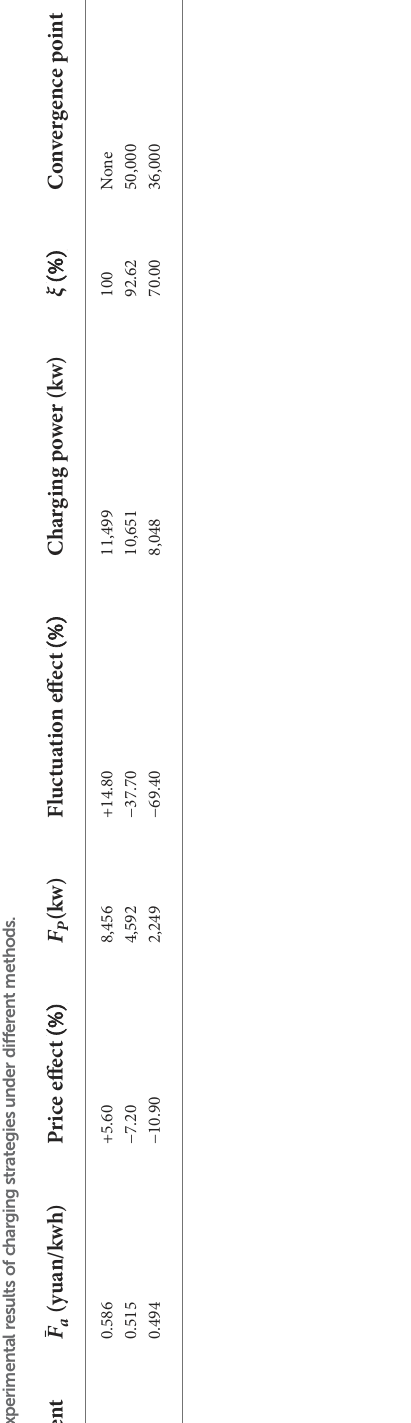
Algorithm 1 outlines the process of learning the optimal policy based on